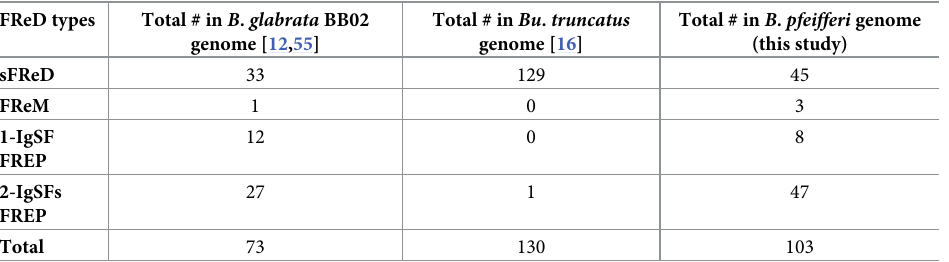
Table 5. Summary of FReDs in B . pfeifferi and two related snail